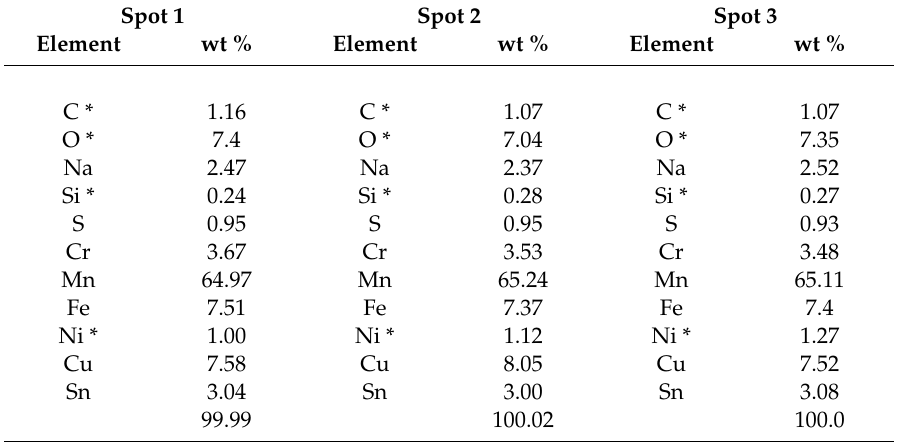
Table 9. Composition of precipitation (Figure 6, right ), determined by EDX. Elements marked with * were manually added.